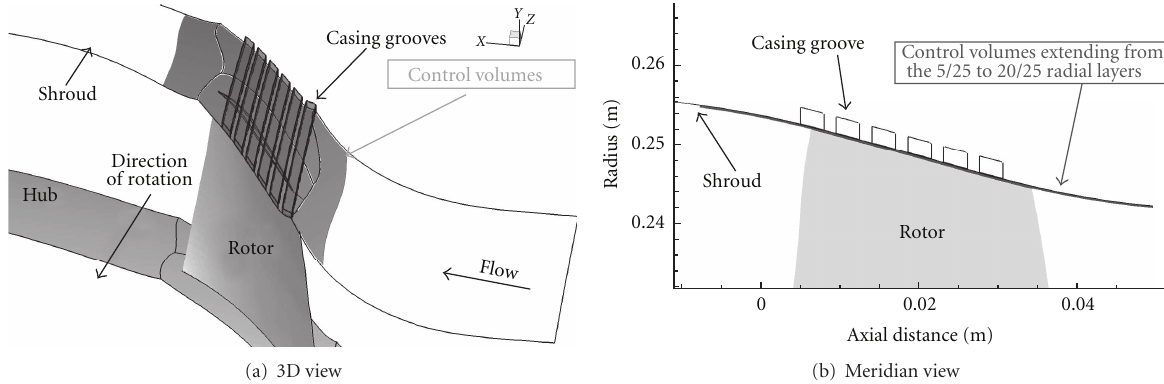
Figure 10: Views of the control volume located the NASA Rotor 37 tip